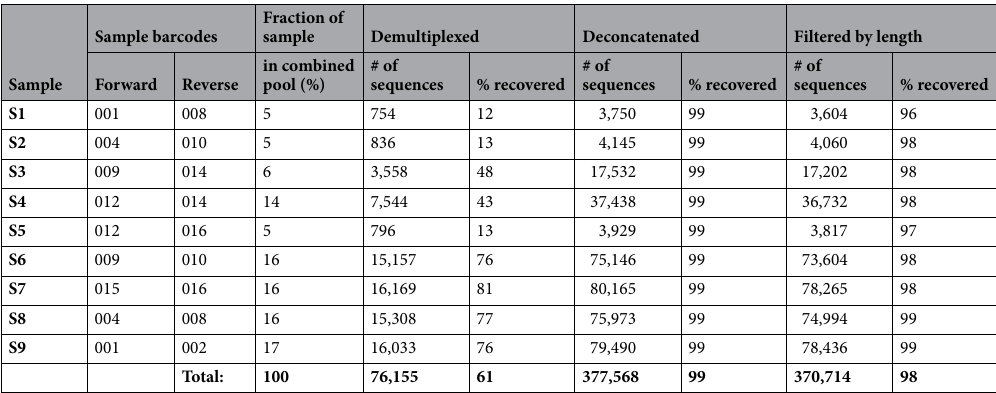
Table 1. Recovery of sequences during the post-sequencing data processing. All nine different DNA library samples, each containing a unique sample specific pair of barcodes, were combined and sequenced in a single flowcell. The samples were pooled at ratios that corresponded to the desired sequencing depth. The number and percentage of recovered sequences after each processing step are shown for each sample (S1-S9) and the combined pool